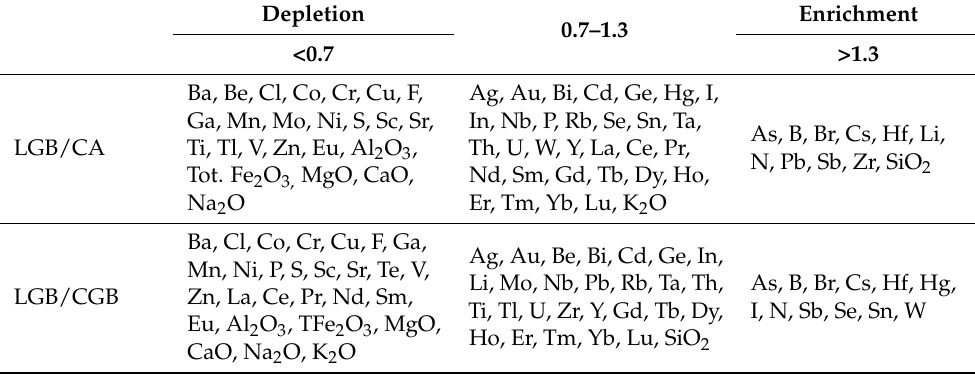
Table 4. Statistical parameter enrichment/depletion coefficient of the 69 elements with the CA and